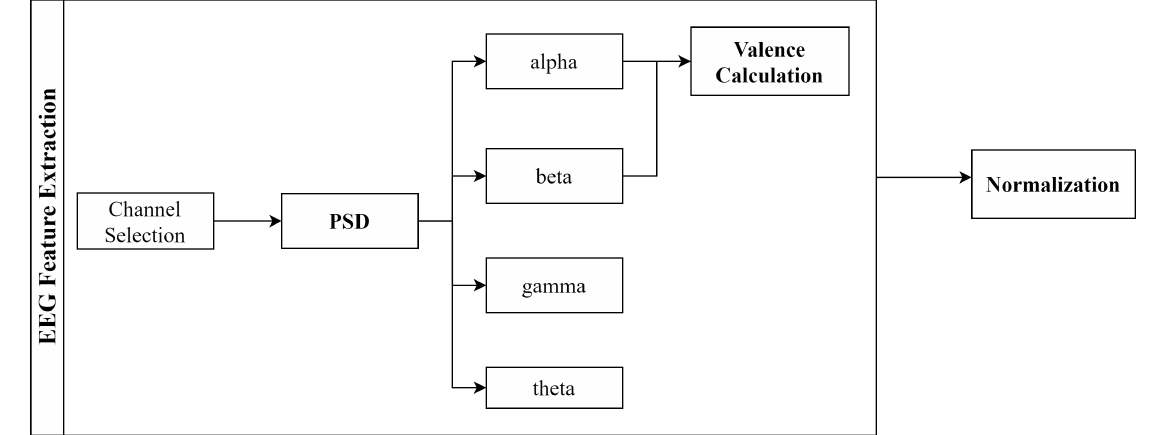
Figure 4. Feature extraction block